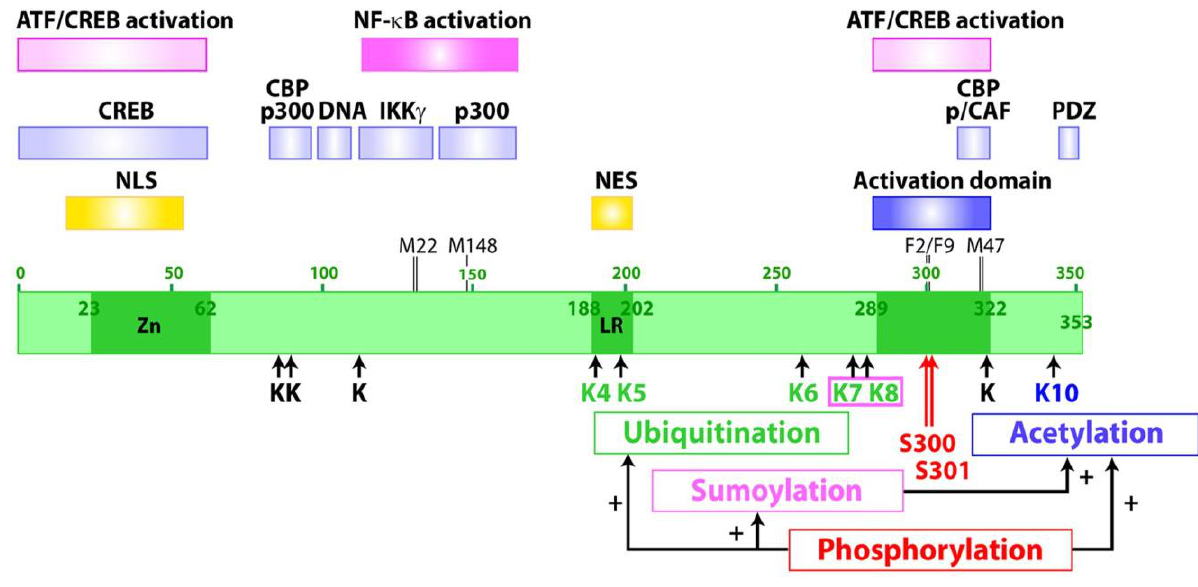
Figure 1. Map of the Tax oncoprotein of HTLV-1. The domains involved in transcriptional activation, in formation of complexes with relevant cellular factors, as well as posttranslational modifications and their crosstalk (arrows marked with a + sign), are shown. NLS, nuclear localization signal; NES, nuclear export signal; Zn, zinc interacting domain; LR, leucine-rich